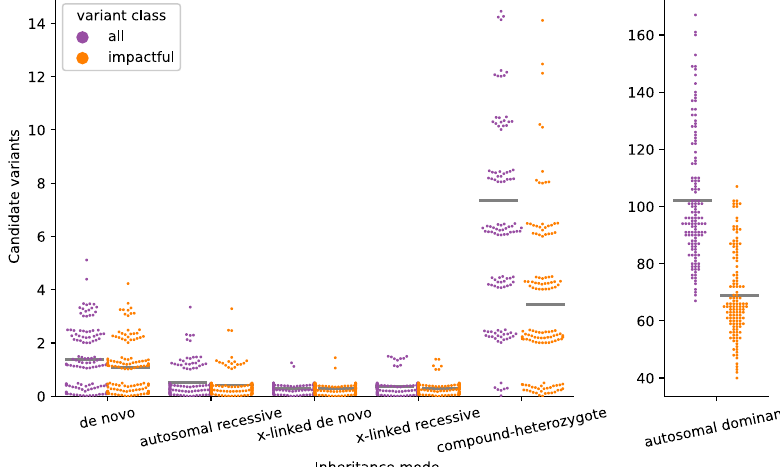
Fig. 3 The number of candidate variants that follow different inheritance modes per exome. The number of candidate variants for 149 exome trios are separated by inheritance mode and colored by variant class. Variants deemed impactful by slivar using annotations from VEP, snpEff, and bcftools. Counts for autosomal dominant variants are shown in a separate plot due to the much larger numbers. Each point represents the number of candidate variants for a single family ( y -axis) passing the inheritance mode ( x -axis), genotype-quality, population allele-frequency, and allele-balance fi lters. Gray bars indicate the mean number for each class and inheritance mode. Points are jittered slightly to allow viewing more samples simultaneously.